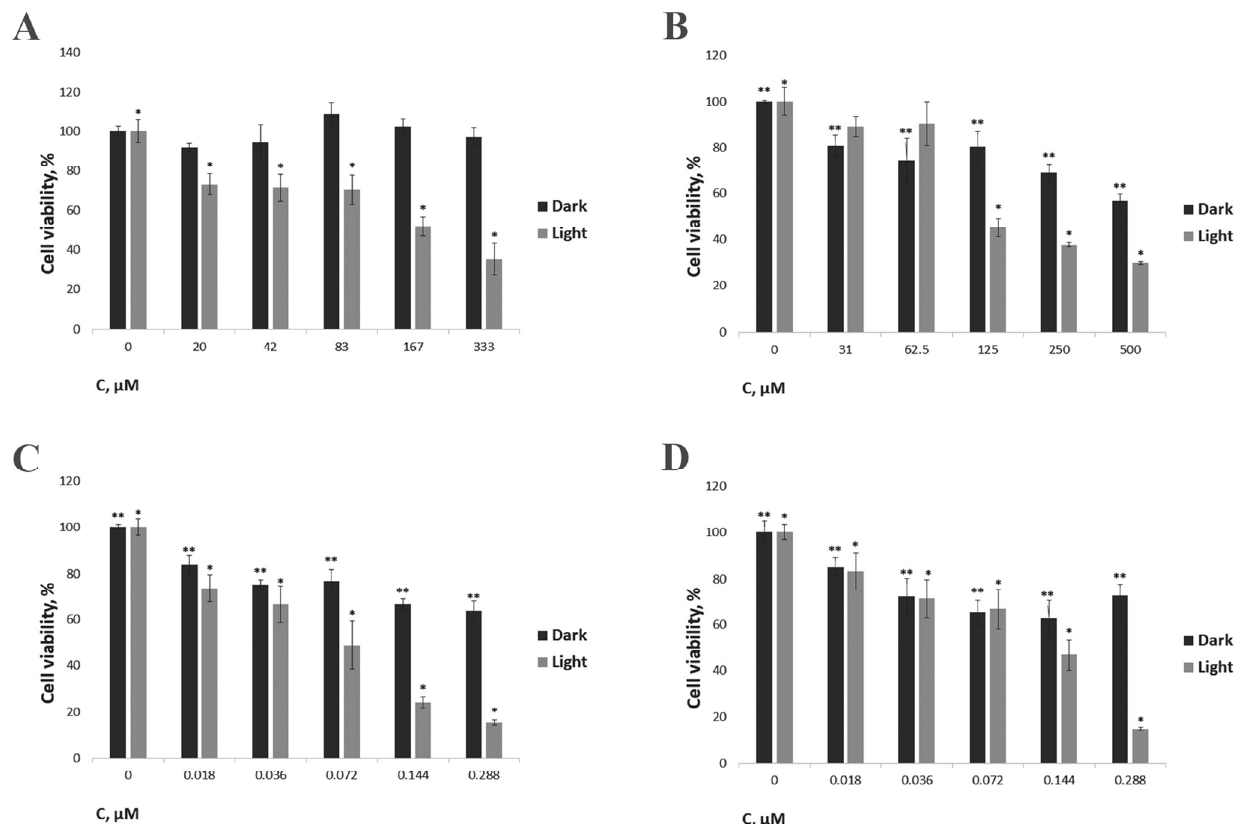
Figure 6. The e ff ect of the developed compound on the viability of MDA-MB-231 and NKE cell lines. ( A ) Conjugate 7 toward MDA-MB-23; ( B ) Conjugate 7 toward NKE; ( C ) Conjugate 7 + F127 toward MDA-MB-23; ( D ) Conjugate 7 + F127 toward NKE. Cells were irradiated for 90 min using a Medical Therapy Philips TL 20W/52 lamp (irradiation dose of 8.073 J/cm 2 ). Cells were incubated with the compound for 24 h. */** indicate statistically signi fi cant di ff erences in cell survival relative to the values with zero concentration of the compound ( p < 0.05).